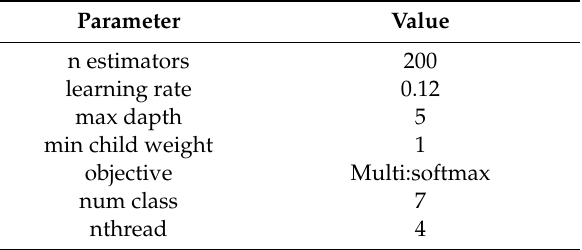
Table 5. Parameters for extreme gradient